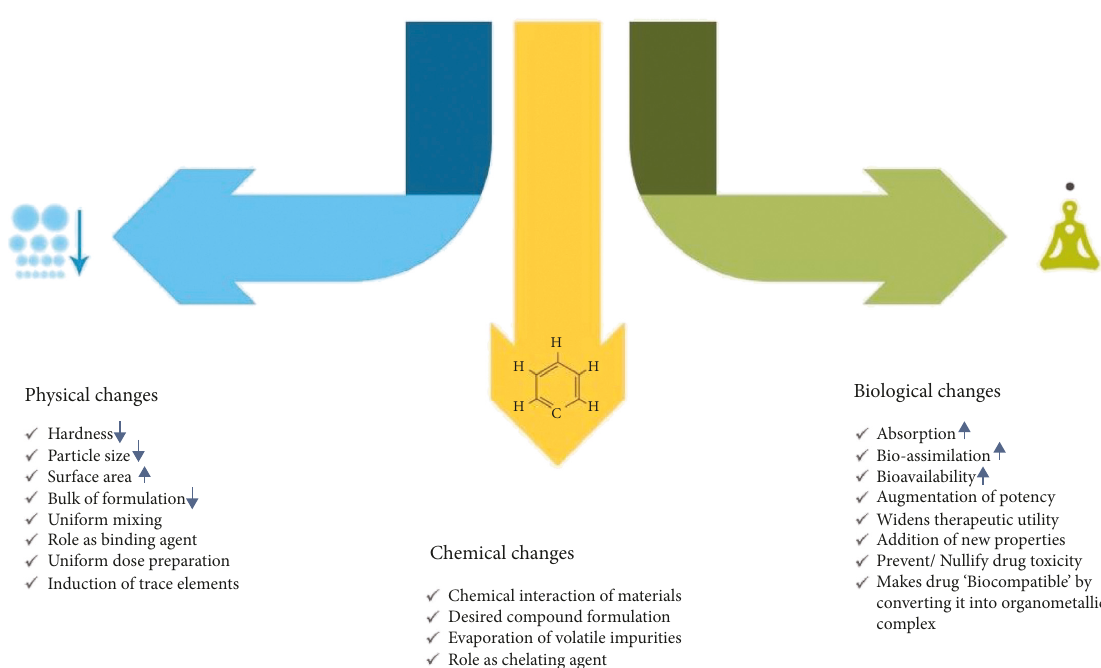
Figure 3: Probable changes and proposed benefits apropos